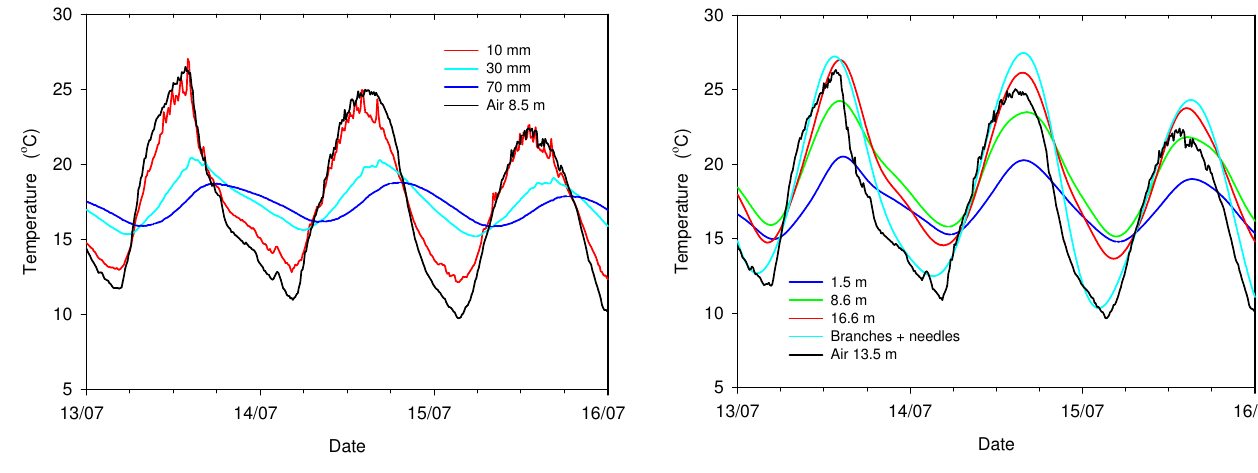
Fig. 1. The azimuthally averaged temperatures at different depths from the bark surface and inwards in the trunk of a pine tree at 8.6m height above ground. Also shown is the air temperature at 8.5m above ground. All values are 10-minute averages.